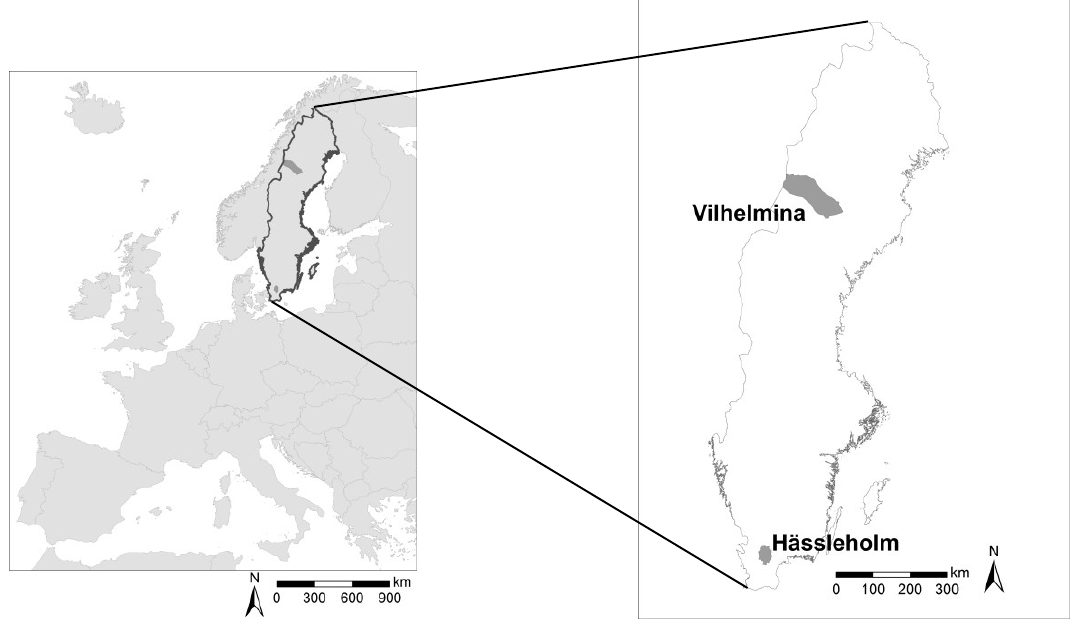
Figure 1. Location of the Hässleholm and Vilhelmina municipalities within